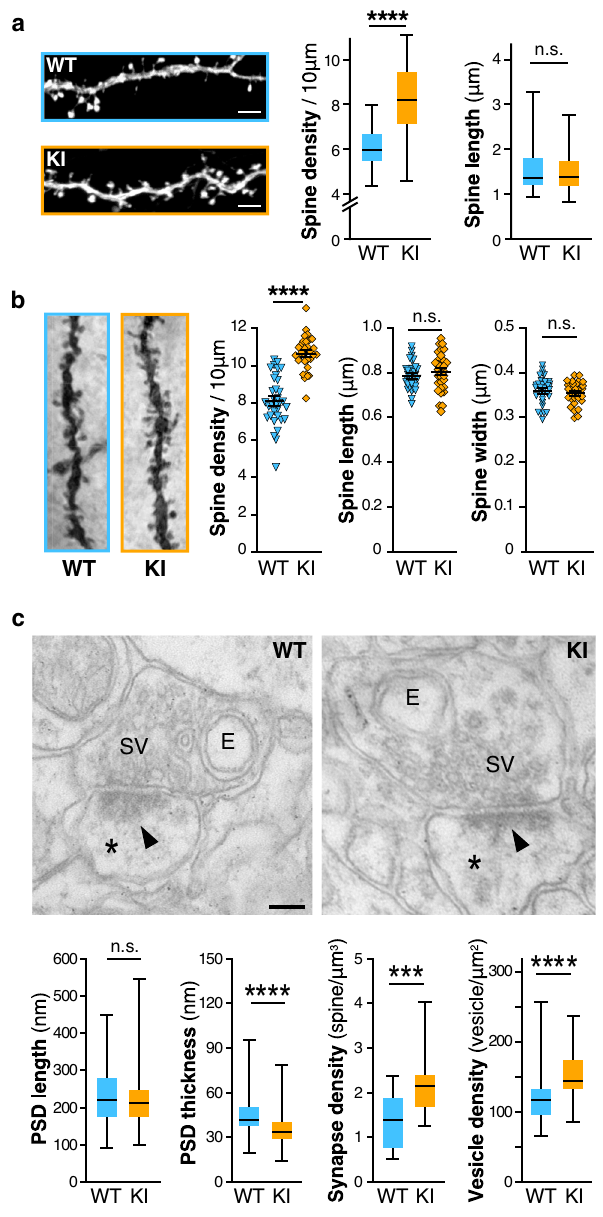
and Fmr1 R138Q cultured hippocampal neurons (Fig. 3b). Using surface-immunolabeling assays with speci fi c anti-GluA1 anti- bodies, we showed that the surface levels of GluA1 in Fmr1 R138Q neurons were signi fi cantly increased (Fig. 3b; Mean surface GluA1 intensity, WT: 1 ± 0.087; Fmr1 R138Q : 1.42 ± 0.13), with a higher density of surface GluA1-containing clusters (Fig. 3b; Surface cluster density, WT: 1 ± 0.049; Fmr1 R138Q : 1.22 ± 0.06). Since AMPARs are often concentrated in dendritic spines, this fi nding corroborates the increased number of dendritic spines measured in Fmr1 R138Q neurons (Fig. 2). We further con fi rmed the signi fi cant increase in GluA1 surface expression in Fmr1 R138Q neurons using cell surface biotinylation assays (Fig. 3c; GluA1 Fmr1 R138Q : 1.85 ± 0.19 vs WT). Interestingly, while there was no alteration in the total levels of GluA2 in the Fmr1 R138Q brain